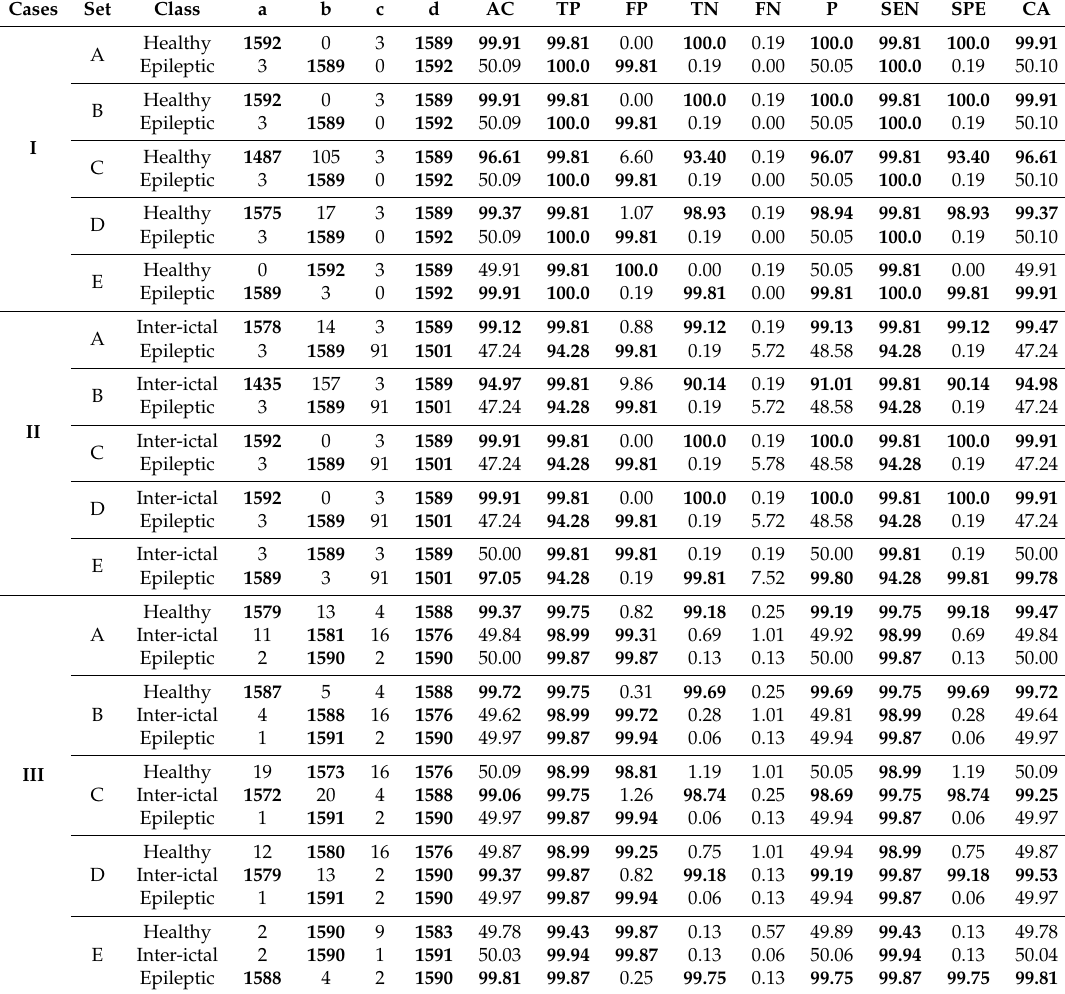
Table 8. The confusion matrix corresponding to the four cases for performance analysis (Back-Propagation Neural Network